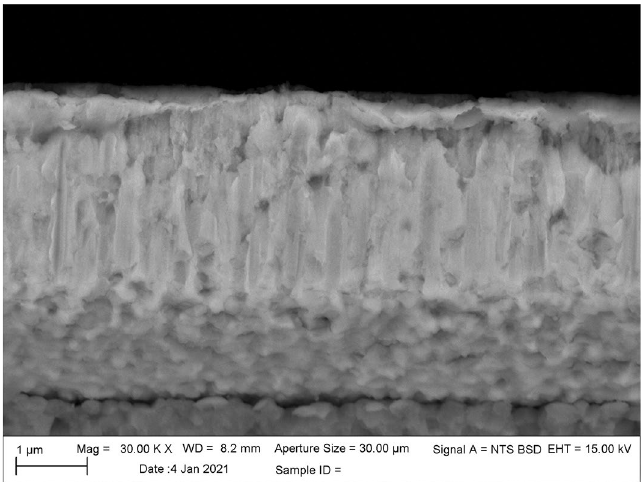
Figure 4. SEM micrograph of a 3 µm thick Pd film deposited onto a 5 µm thick Cu film after heating to 500 °C.